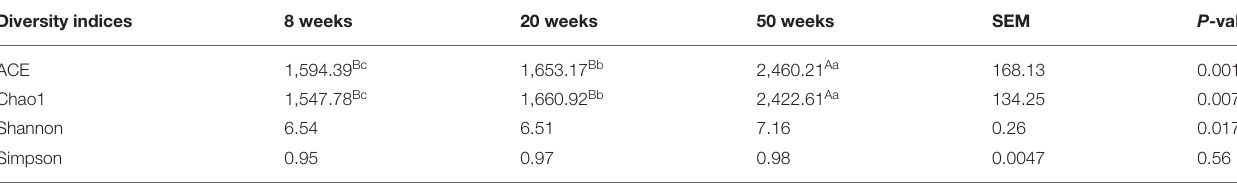
TABLE 3 | Comparison of α -diversity indices among different growth periods. Diversity